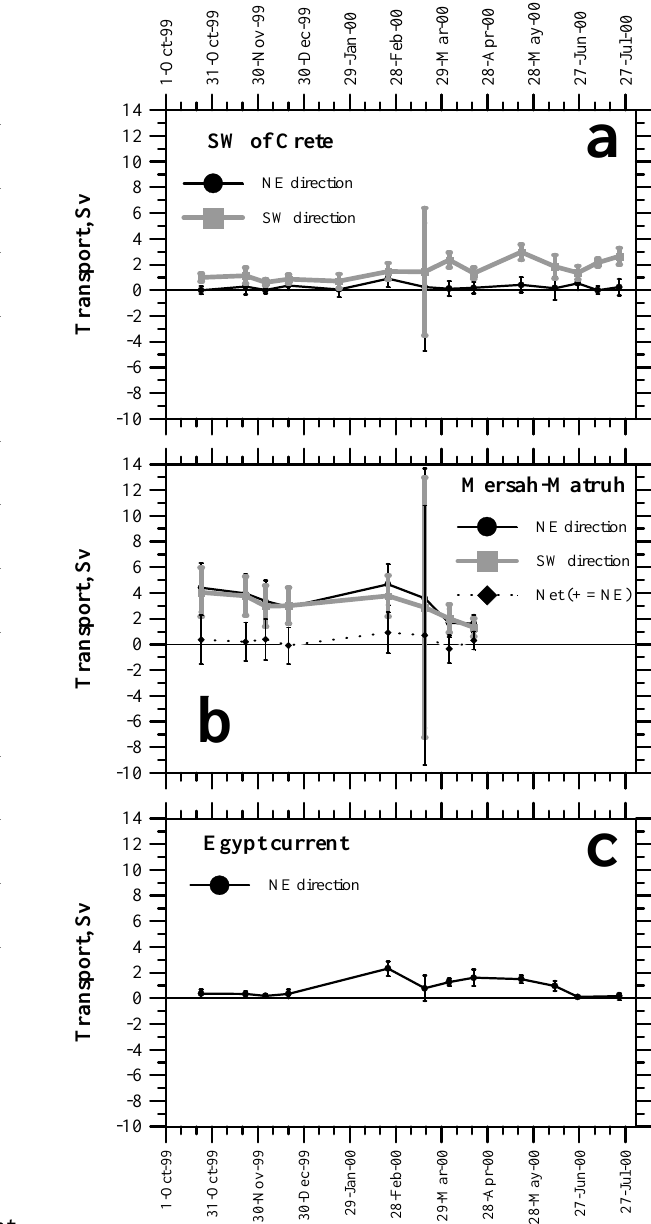
Fig. 8. Estimated transports for (a) the southwestward current SW of Crete, (b) the Mersah – Matruh gyre and (c) the coastal current off the Egyptian